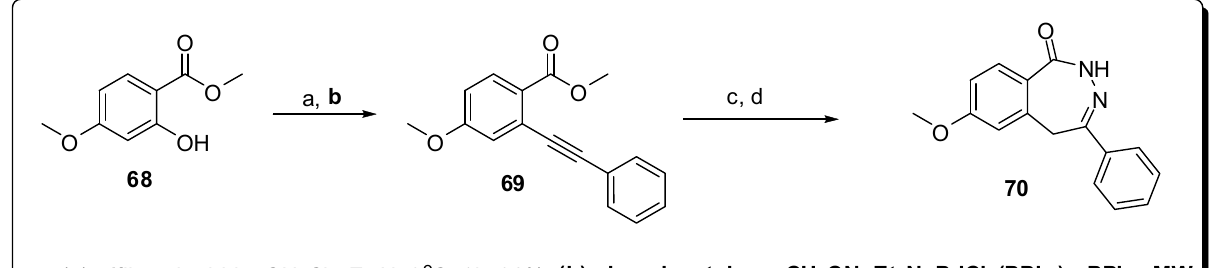
Figure 22. Use of MAOS to construct benzodiazepinone